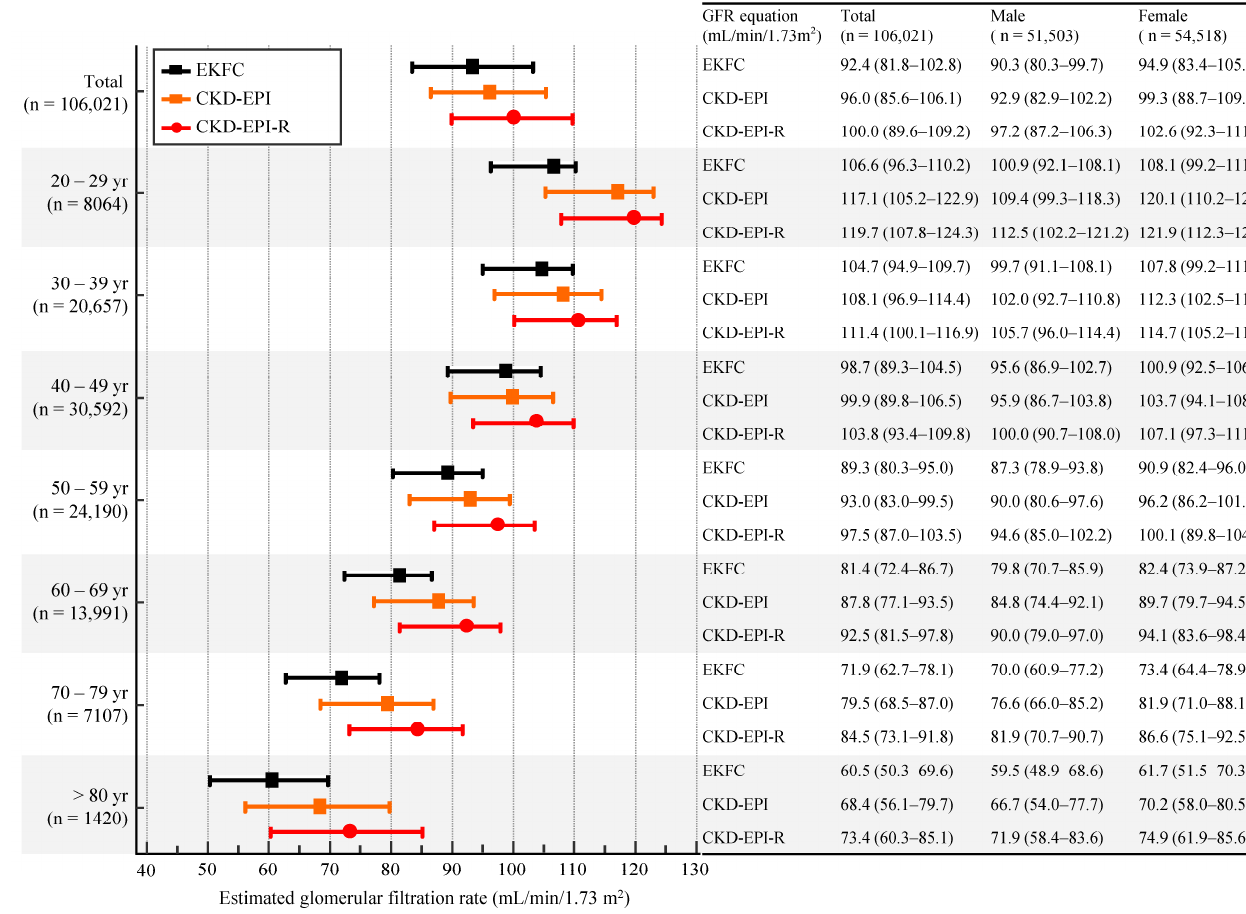
Figure 2. Distribution of eGFR using serum creatinine-based CKD-EPI, EKFC, and CKD-EPI-R equations stratified by age group and gender. Data are presented as median and interquartile range. Abbreviations: see Table 1.